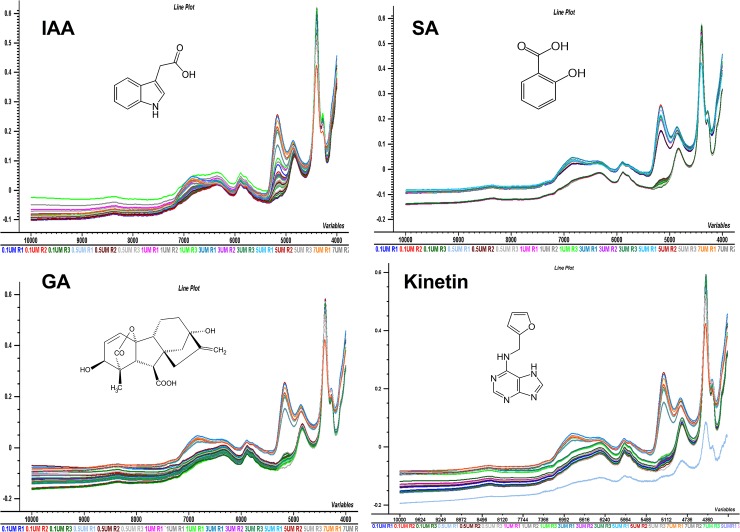
NIRS data spectra of populations.NIRS data spectra for IAA, SA, Kinetin and GA and 13 different populations of B. sacra samples. The figure elucidates the scattering effect due to absorbance without preprocessing on wavelength range from 10000 to 4000 cm-1.